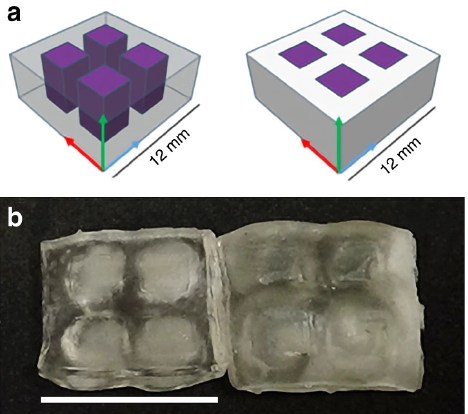
Figure 20. Multi-material printed part using DLP with UV and visible light exposure, where ( a ) shows the geometry of the part with UV irradiated sections highlighted in purple, and ( b ) shows the finished print with ( left ) no thermal post-cure and ( right ) 3-h thermal post-cure at 60 °C. Here, the scale bar represents 12 mm [120].